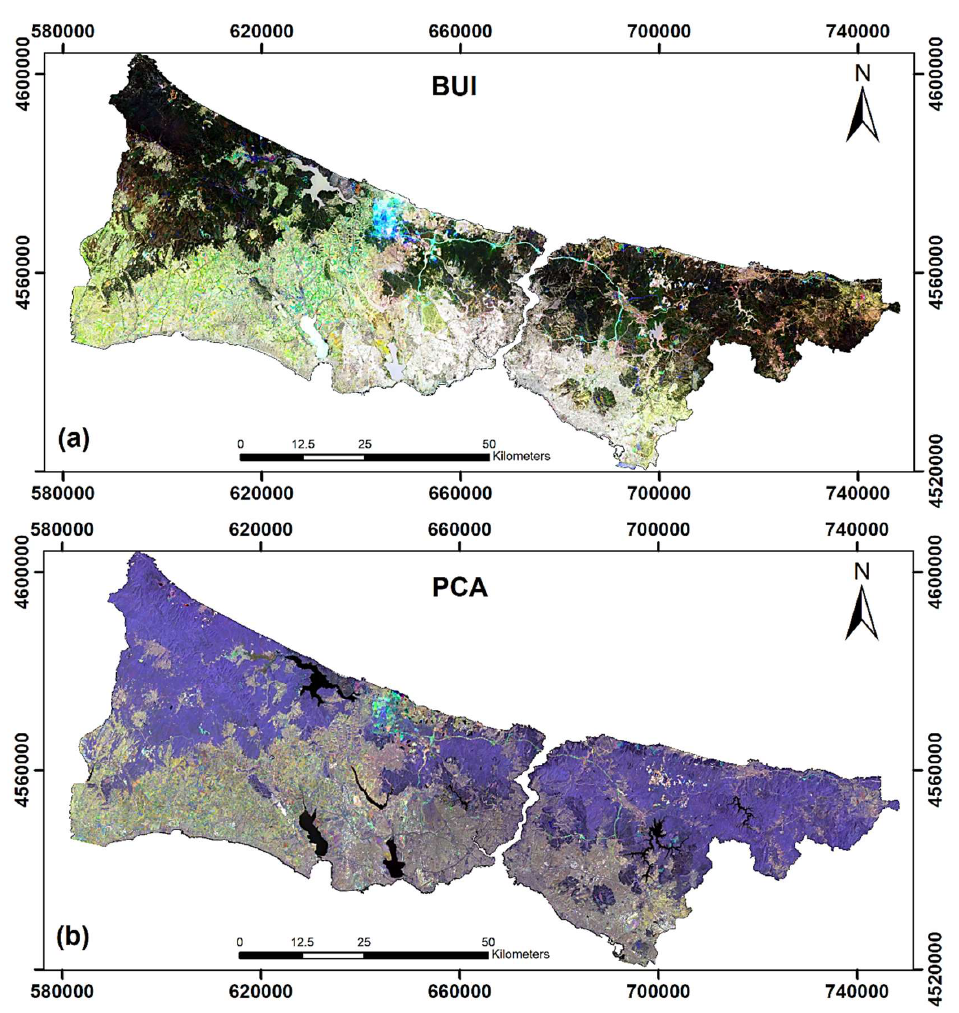
Figure 2. Red/Green/Blue (RGB) view of the dimension reduction results: ( a ) built-up index (BUI) layer stack and ( b ) principal component analysis (PCA) layer stack (R: 2013/G: 2015/B: 2017).